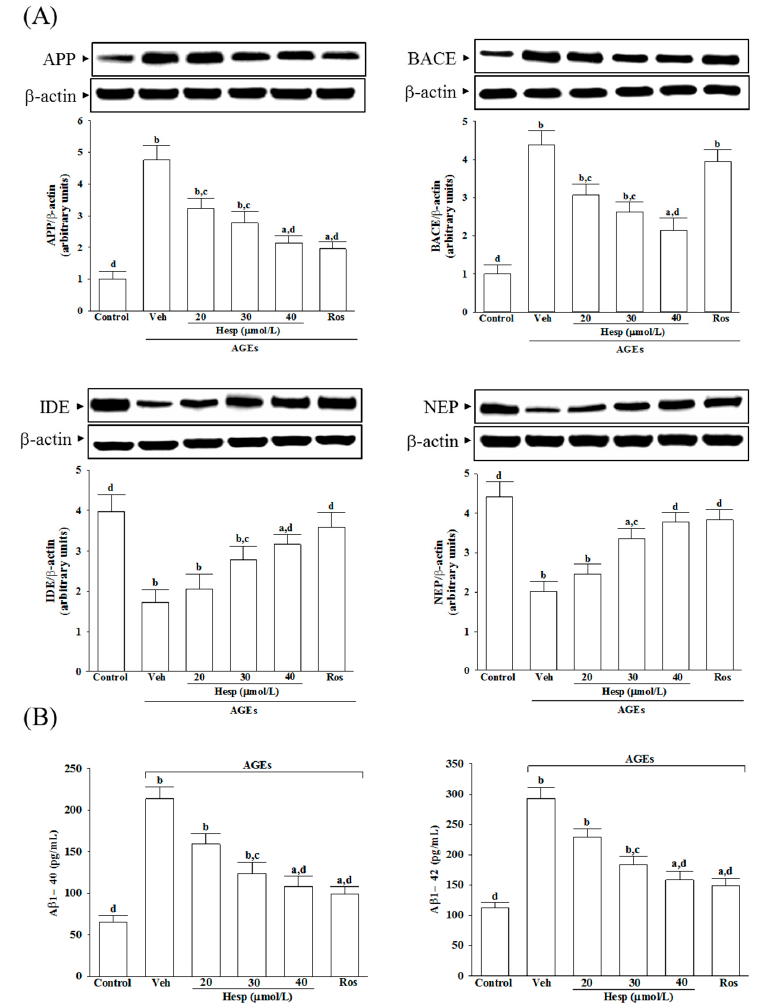
Figure 3. Changes in APP processing and A β secretion in SH-SY5Y cells under AGE stimulation. Cells were received 1 h pretreatment with hesperetin (hesp; 20–40 µ mol/L) or rosiglitazone (Ros; 10 µ mol/L), continued to 24 h AGE (200 µ g/mL) exposure. ( A ) A representative Western blot analyzes insulin degrading enzyme (IDE), and neprilysin (NEP). Band densities were normalized with β